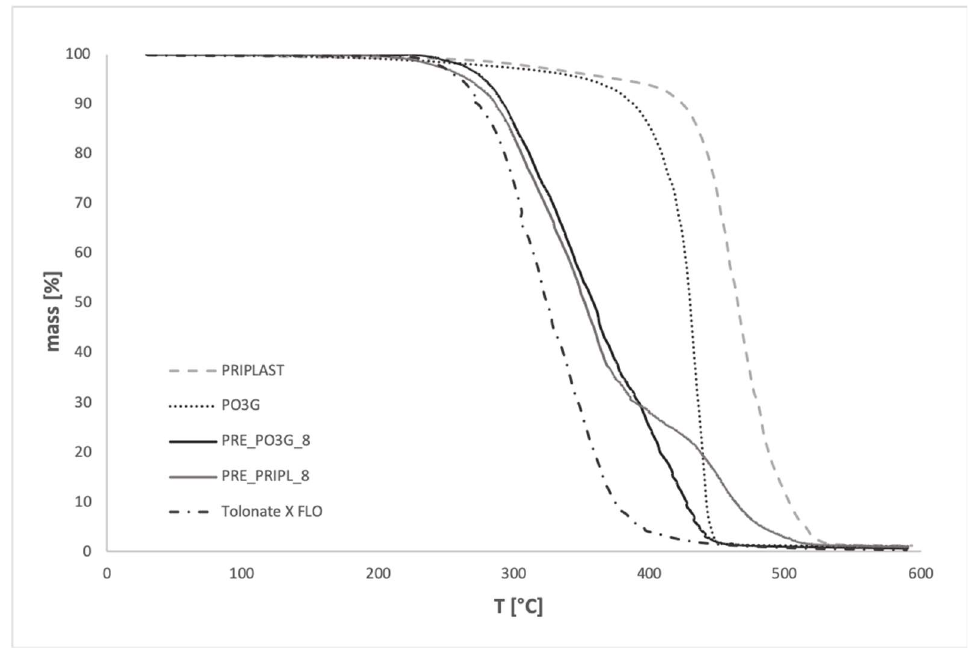
Figure 8. Dependence of TG in function of temperature for monomers and the obtained bio-based prepolymers with NCO ca. 8%.